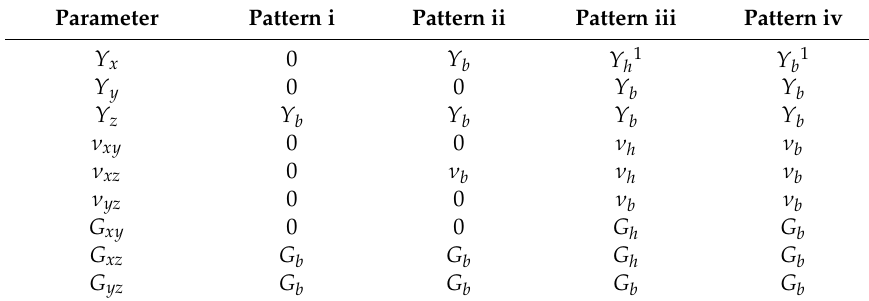
E ff ective mechanical properties of the four joint patterns of mortarless refractory masonry